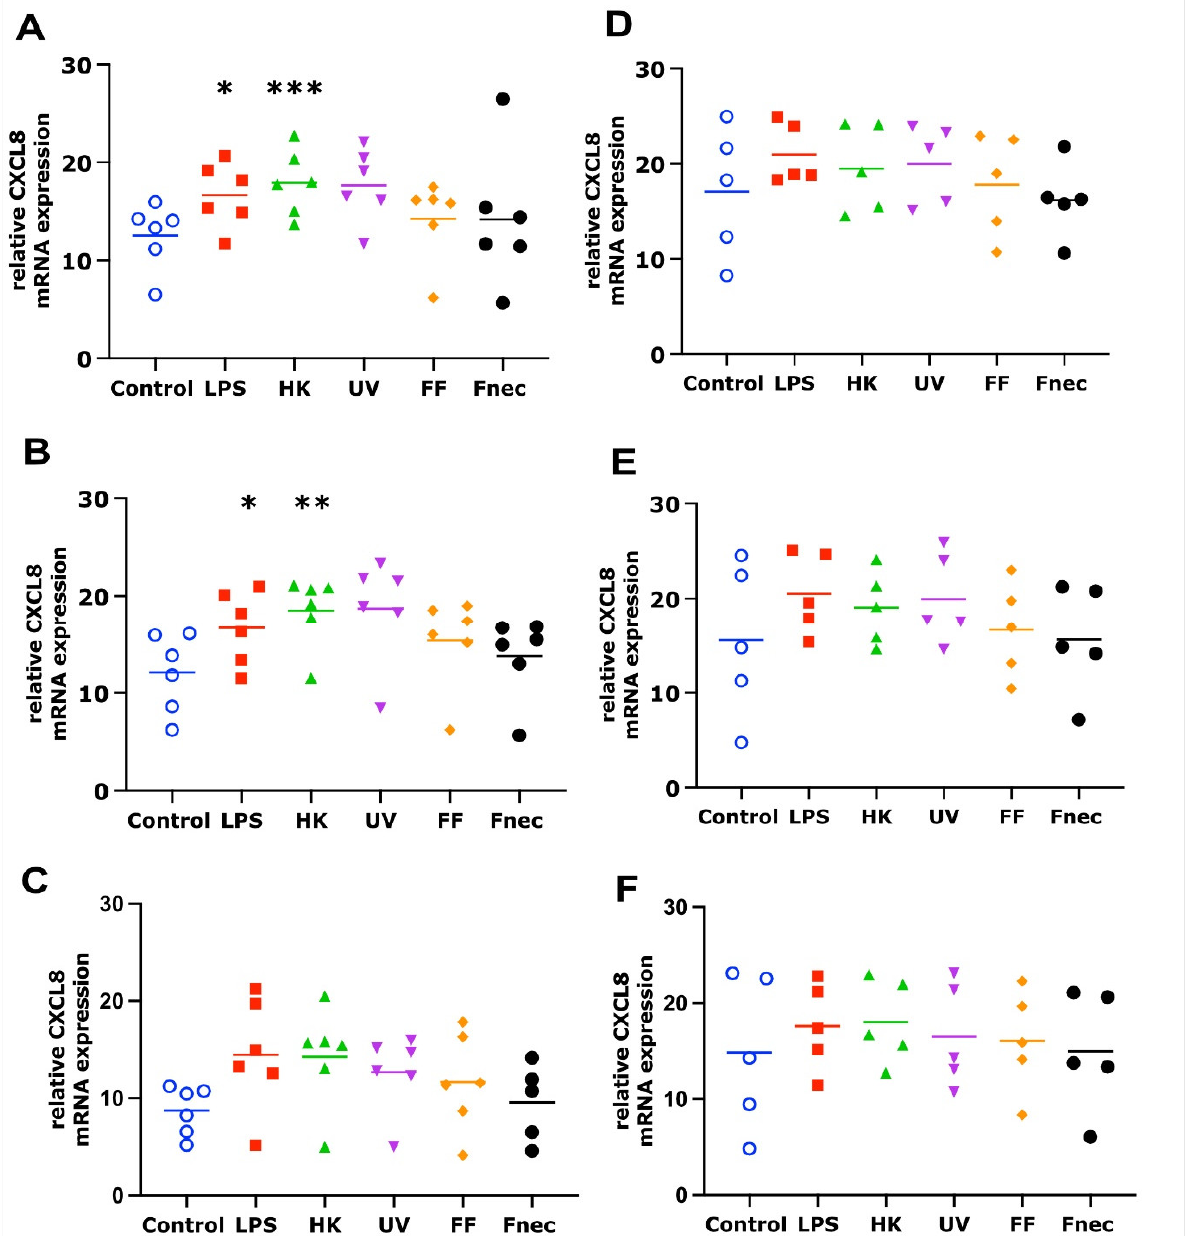
Figure 3. CXCL8 mRNA expression in interdigital ovine fibroblasts. Primary fibroblasts free of M. fermentans ( n = 6, ( A – C )) or naturally infected with M. fermentans ( n = 5, ( D – F )) were stimulated with 1 μg/mL E. coli LPS, heat-inactivated D. nodosus (HK), UV-inactivated D. nodosus (UV), formalin-fixed D. nodosus (FF) or heat-inactivated F. necrophorum (Fnec) (cell culture medium was used as diluent and control) for 2 h ( A , D ), 8 h ( B , E ) and 24 h ( C , F ). Horizontal line indicates the mean. Each replicated symbol represents a different cell line from an individual sheep. One-way-ANOVA, followed by Dunnett’s multiple comparisons test: * p < 0.05, ** p ≤ 0.01, *** p ≤ 0.001.